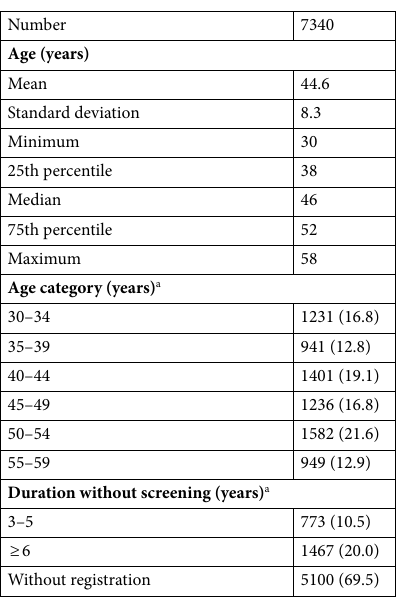
ITS Ordered self-sampling HPV test kit Ordered through website Returned